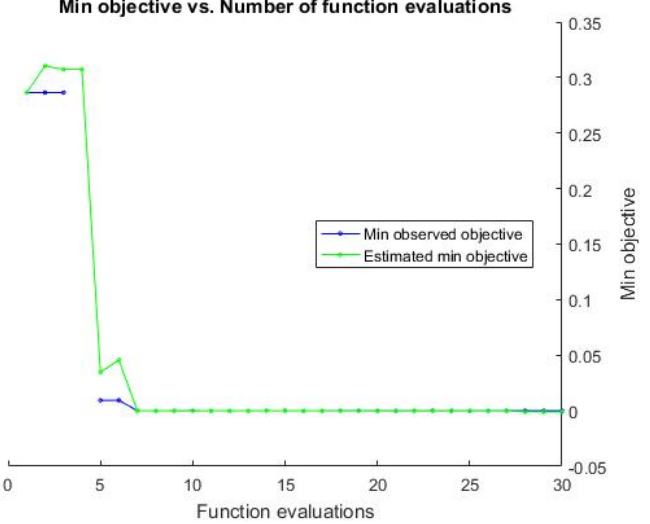
Figure A6. Objective function model for the k-NN classifier trained for the first mode of the second learning scheme (higher precision of localization).